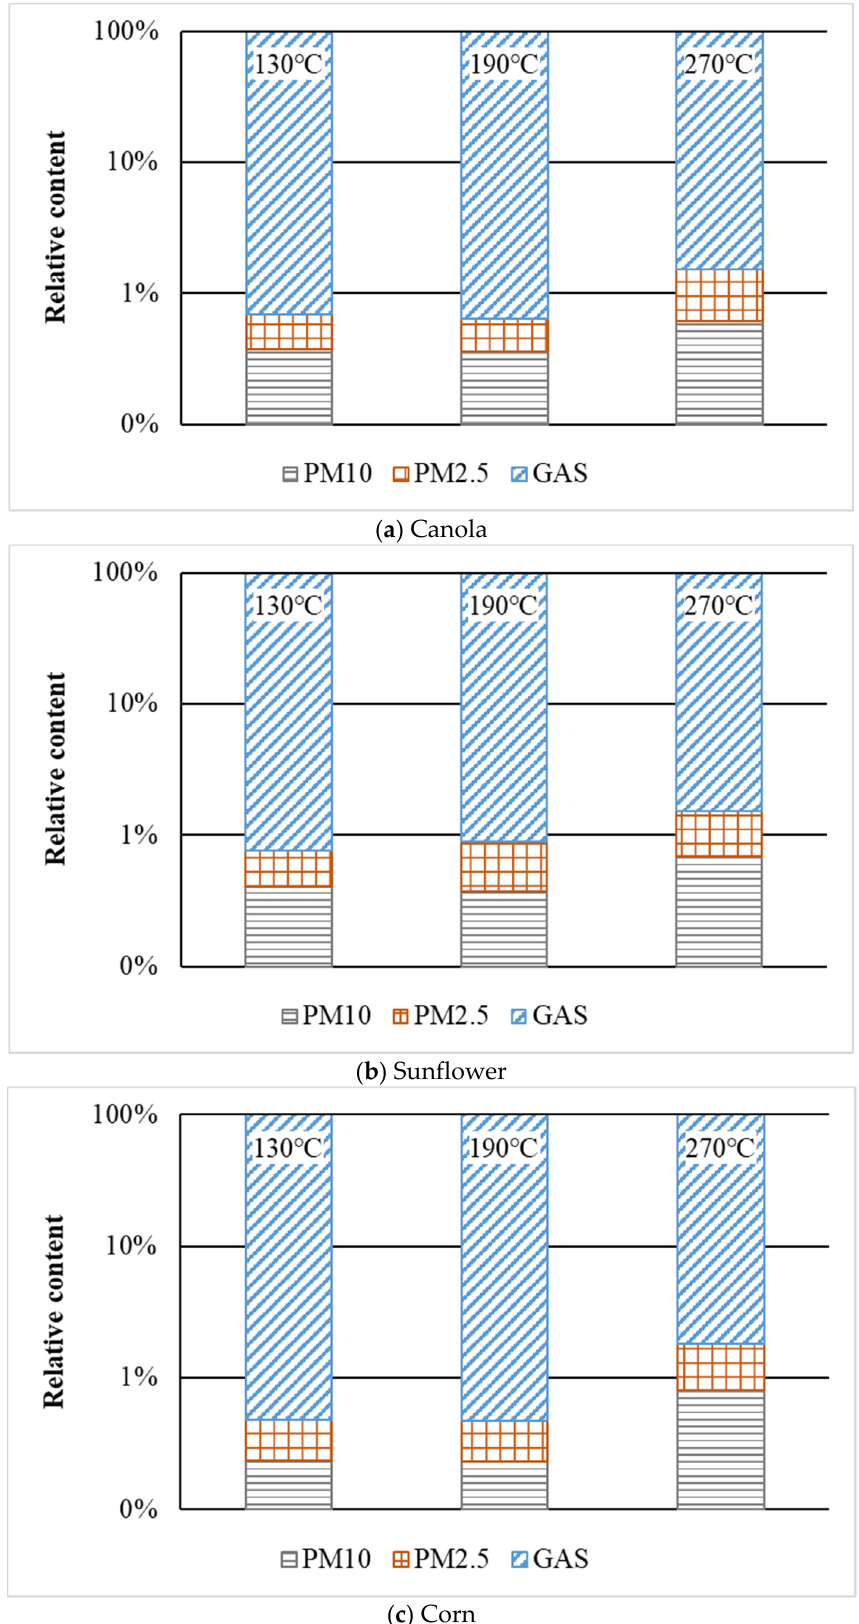
Figure 4. Distribution of VOCs emission forms at different temperatures.